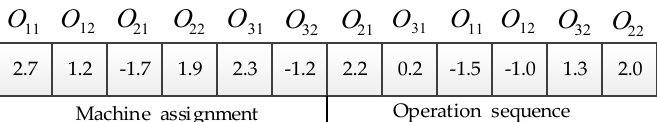
Figure 2. Individual position vector.